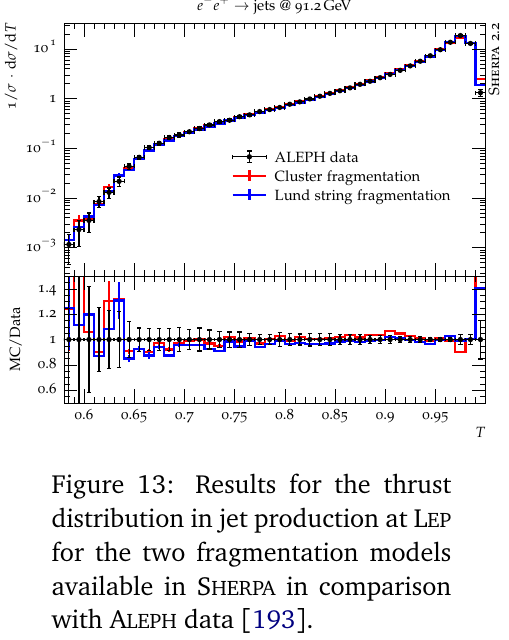
Figure 14: Results for the distribu- tion of the total jet broadening at L EP for the two fragmentation mod- els available in S HERPA in compari- son with A LEPH data [ 193 ]